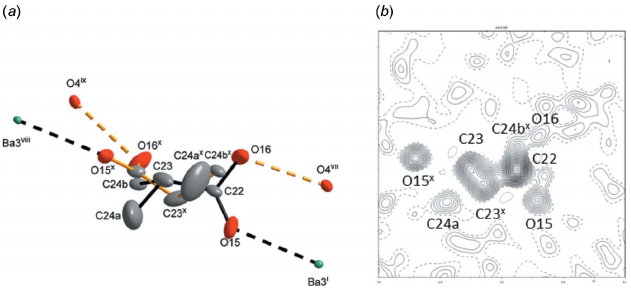
Figure 5 ( a ) A view of a disordered propionic acid molecule with displacement ellipsoids shown at the 30% probability level. ( b ) Section of the difference electron density map (Petrˇı´cˇek et al. , 2014) through the atoms C22, C23 and C24 b x . This section shows the region of the disordered propionic acid molecule in part. Increments of positive and negative contours are 0.01 and 0.05 e A˚ (cid:4) 3 . [Symmetry codes: (i) x (cid:4) 1 (cid:4) z + 1; (vii) (cid:4) x + 1, (cid:4) y , (cid:4) z + 1; (viii) (cid:4) x + 3 The disordered atoms are related by a symmetry operation (Wyckoff position c ) ( x ) (cid:4) x + 1, y , (cid:4) z + 1/29. For colours, see caption for Fig. 1.